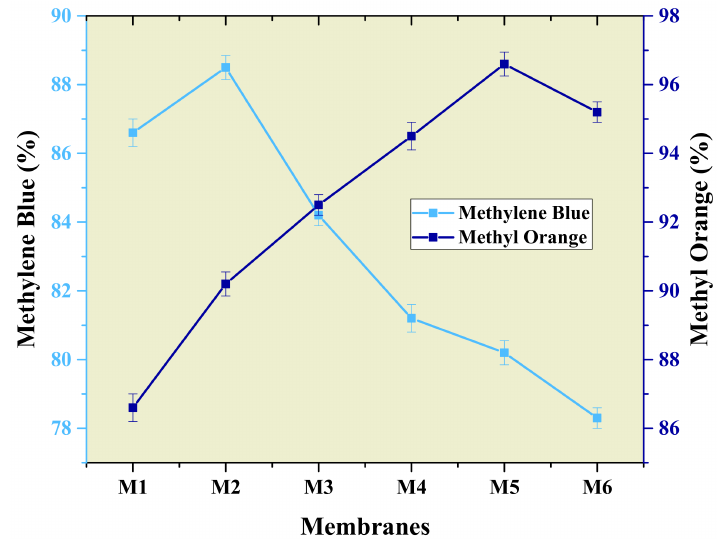
Figure 12. Trend of rejection of dyes through aminated graphene oxide–based PVDF